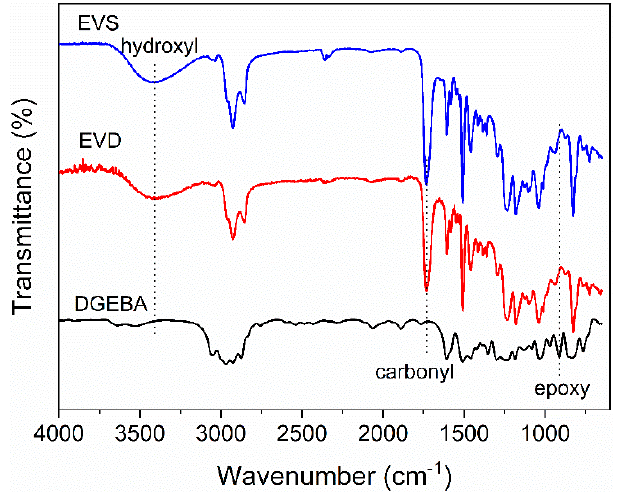
Figure 3. FT-IR spectra of DGEBA, epoxy vitrimers prepared by dynamic crosslinking (EVD), and epoxy vitrimers prepared by static curing (EVS).